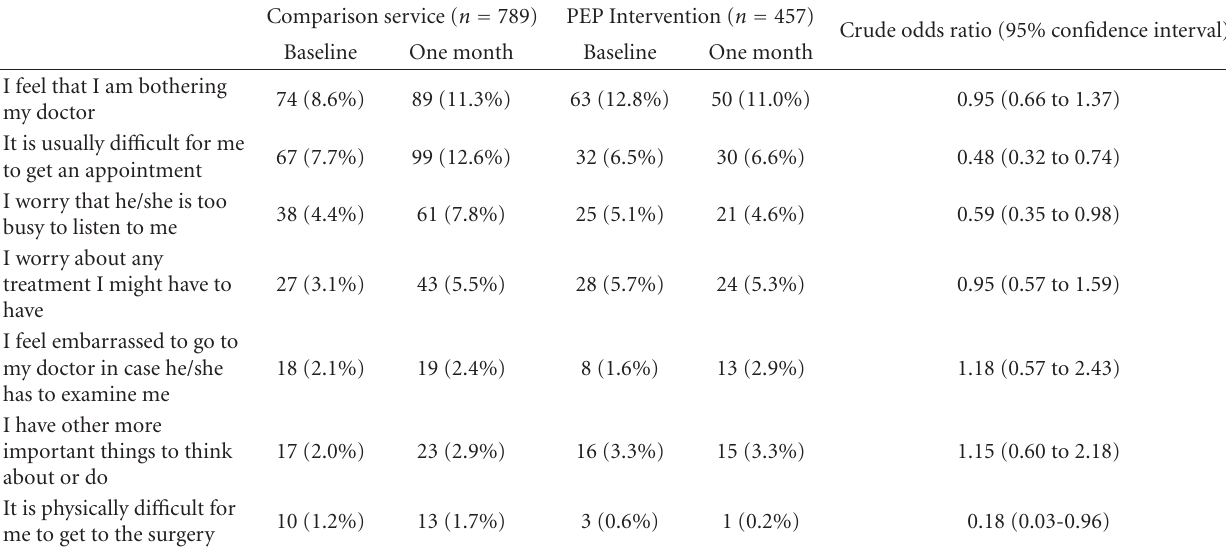
Table 3: Change in reported barriers to seeing a doctor with a health